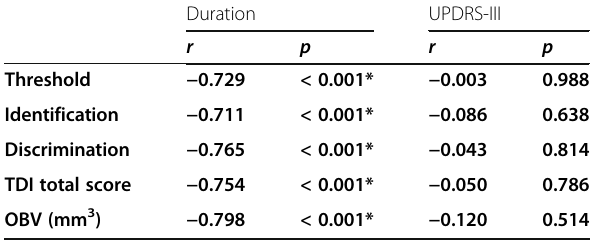
Table 4 Correlations between each of Sniffin Stick test and olfactory bulb volumetry with disease duration and severity among Parkinson disease patients ’ group